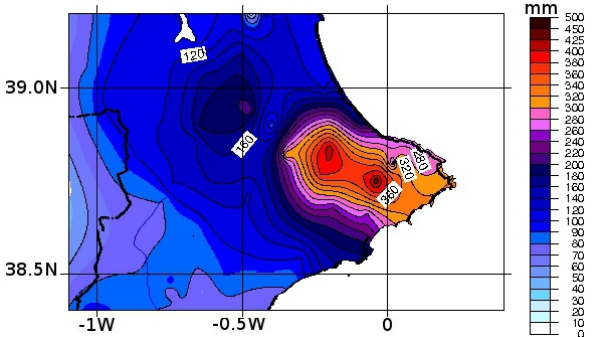
Fig. 6. 48-h accumulated precipitation (11–12 October 2007). Data recorded by CEAM Meteorology Department, AEMET and Con- federaci´on Hidrogr´afica del J´ucar